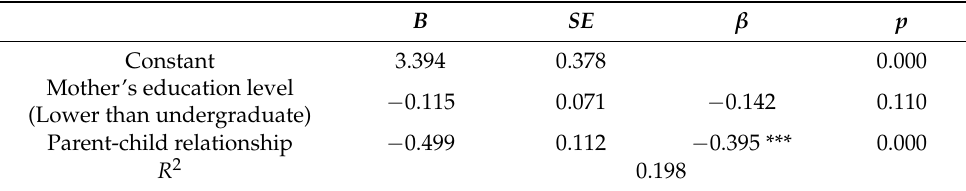
Table 4. The regression result with a mediator.